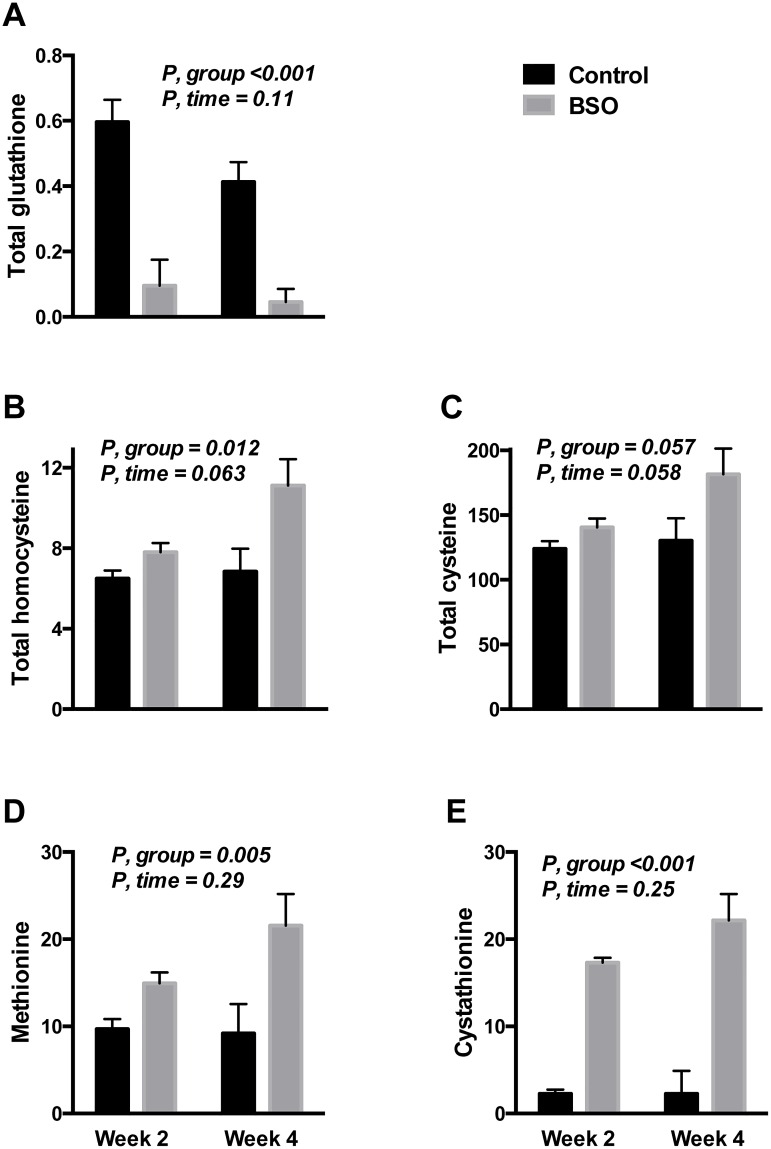
Effect of BSO on urine excretion of glutathione and upstream sulfur amino acids.A-E: Urine concentration of total glutathione, methionine, total homocysteine, cystathionine and total cysteine, in nmol/μmol creatinine during the 2nd and 4th weeks of BSO treatment. Depicted P values are from repeated measures ANOVA. N = 6 BSO-treated mice, and 8 controls. Data is from a different cohort of mice of the same age and sex.